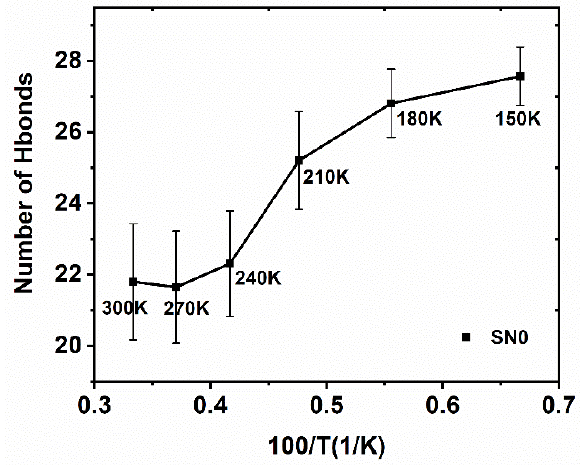
Figure 7. The relationship between the temperature and number of hydrogen bonds formed by water and the selected region of protein. Statistics on 1900 frames with standard deviation.